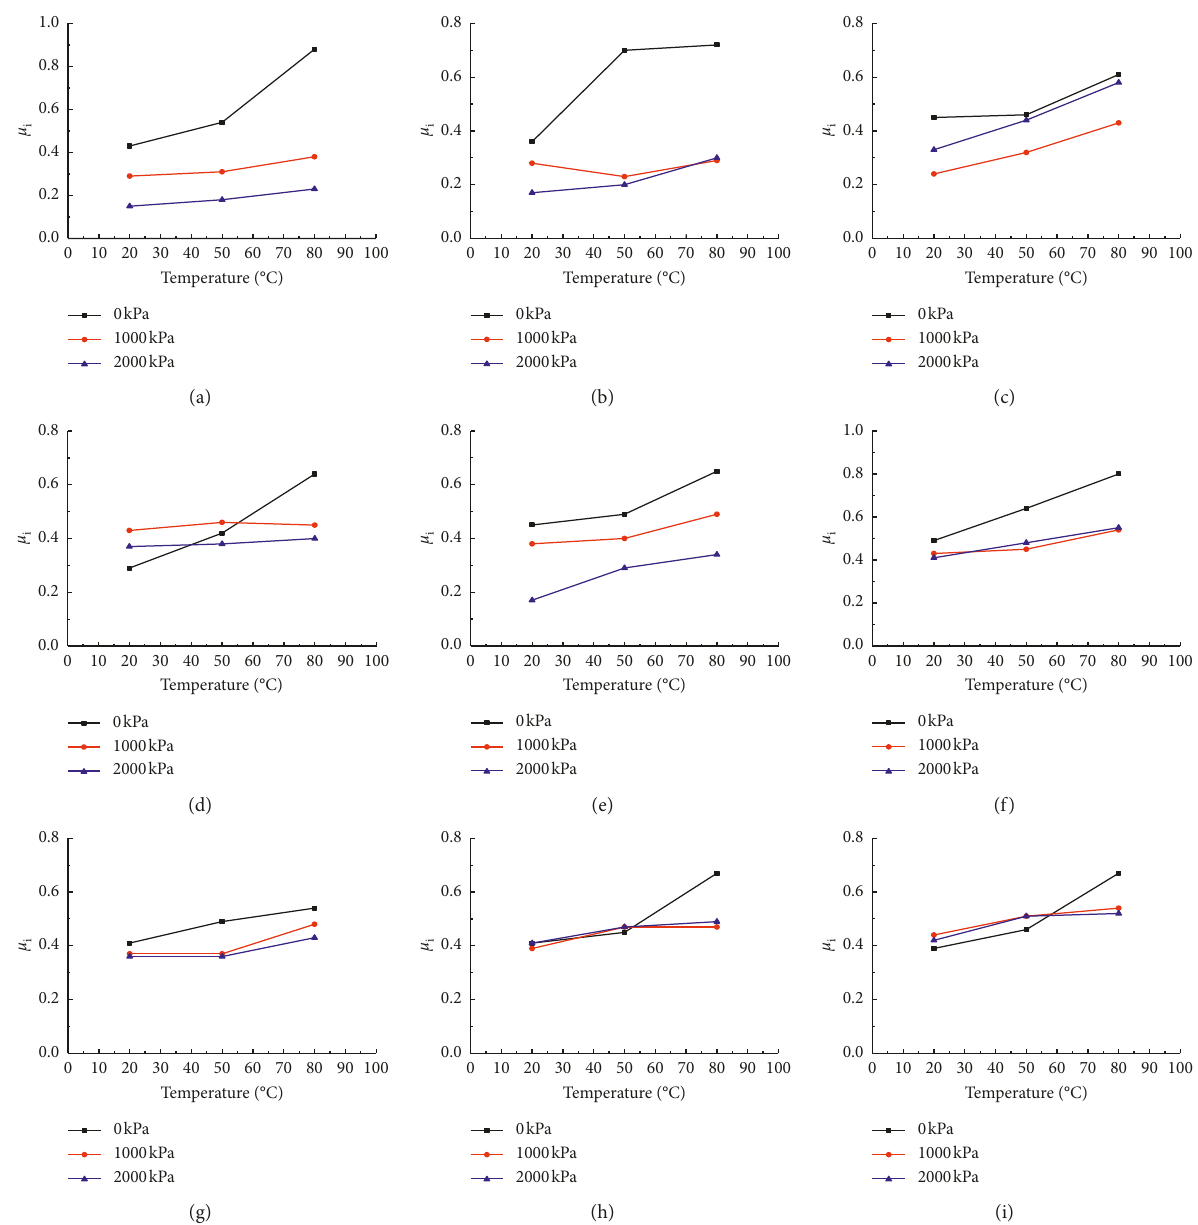
Figure 11: The relationship curves of Poisson’s ratio with temperature under different water contents, dry densities, and confining � 1.4g/cm 3 , w � 5%. (b) ρ pressures. (a) ρ d � 15%. (f) ρ � 1.6 g/cm 3 , w � 25%. (g) ρ d